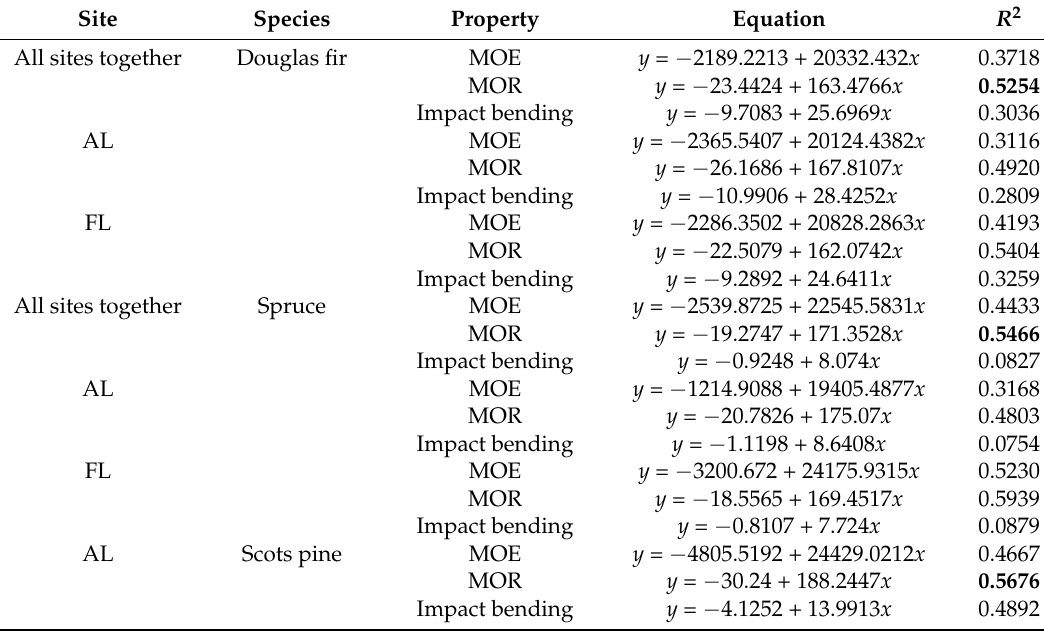
Table 6. Correlation between density and the tested mechanical